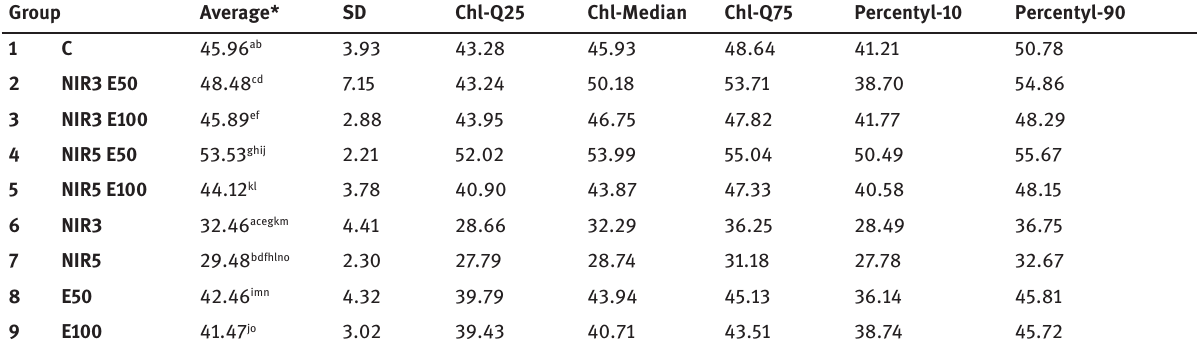
Table 4: Descriptive statistics for the measurements of chlorophyll by SPAD method in abnormal soybean seeds.